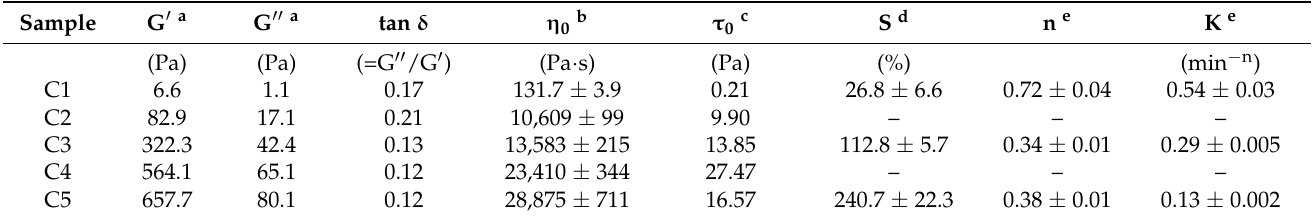
Table 2. Rheological and swelling parameters of CS/PEG/Lap dispersions and films,